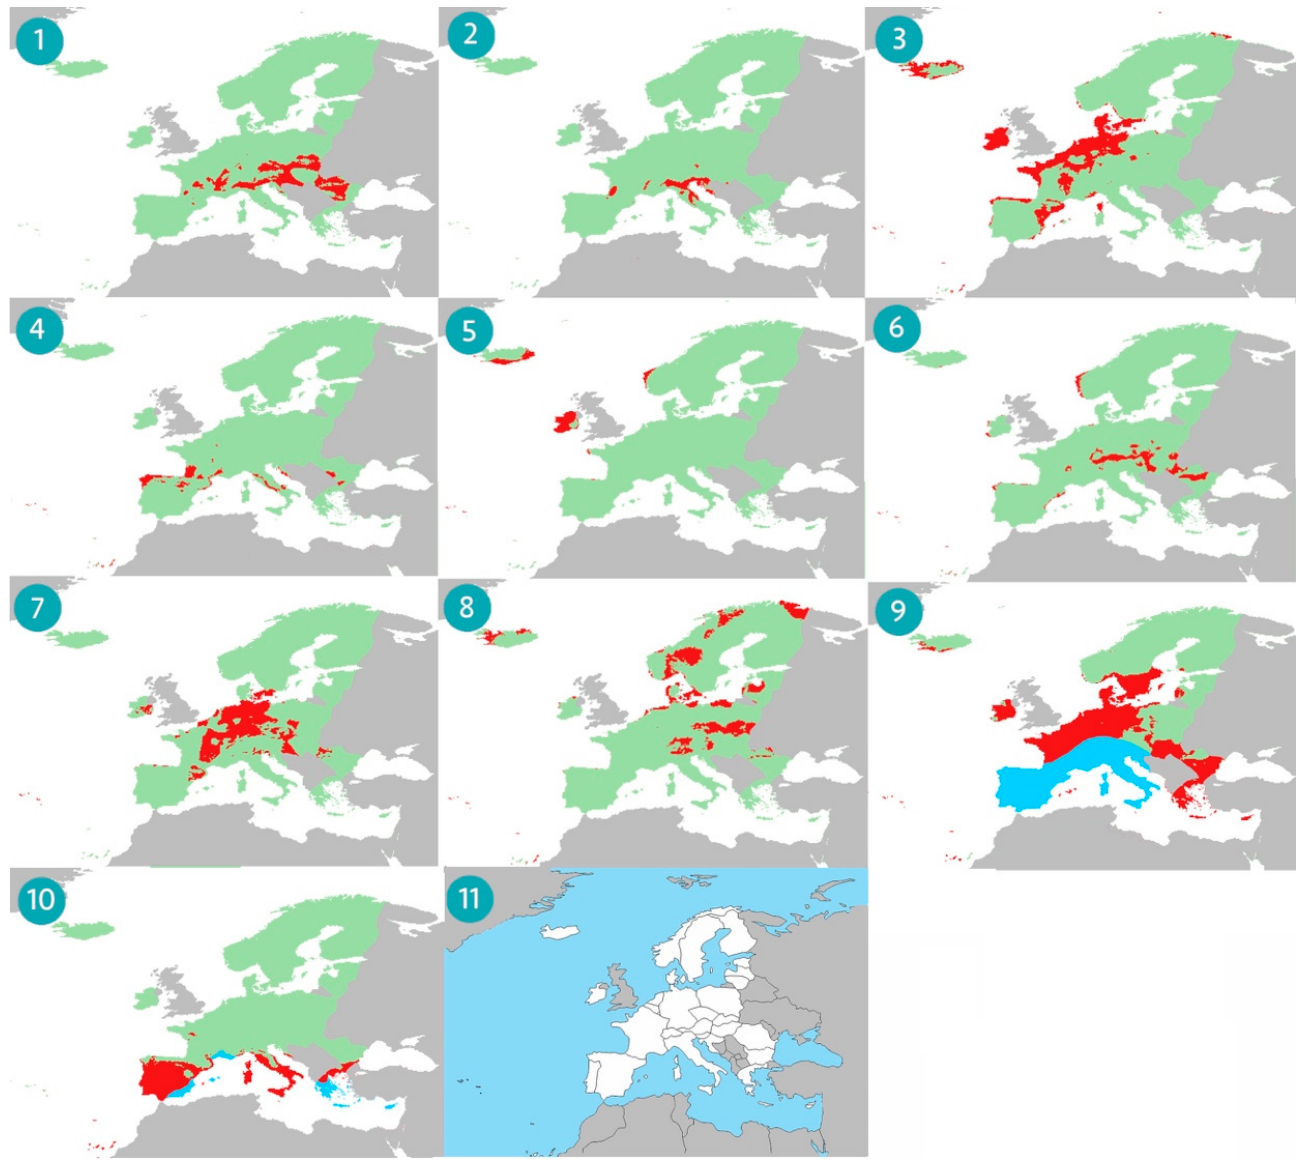
Figure 1. The prediction computed using the MaxEnt model of the pet-traded gastropods with potential occurrence in a “large area” of EU (= covered more than 5% of the territory). The maps show native range in blue and suitability in red, representing a high probability of establishment for these species: ( 1 ) Anguispira alternata , ( 2 ) A. strongylodes , ( 3 ) Cochlitoma varicosa , ( 4 ) Hadra webbi , ( 5 ) Helicophanta bicingulata , ( 6 ) Laevicaulis altea , ( 7 ) Megalobulimus oblongus , ( 8 ) Phaedusa paviei , ( 9 ) Rumina decollata , and ( 10 ) R. saharica ; ( 11 ) map of European Union.